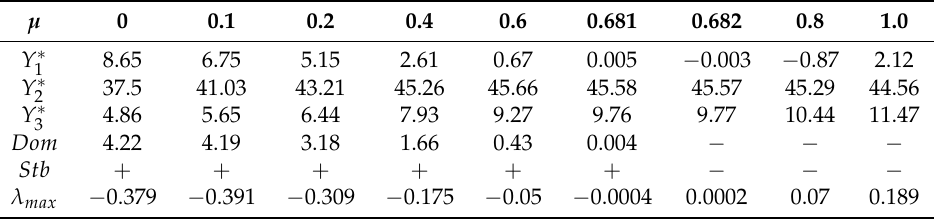
Table 2. Full profitability